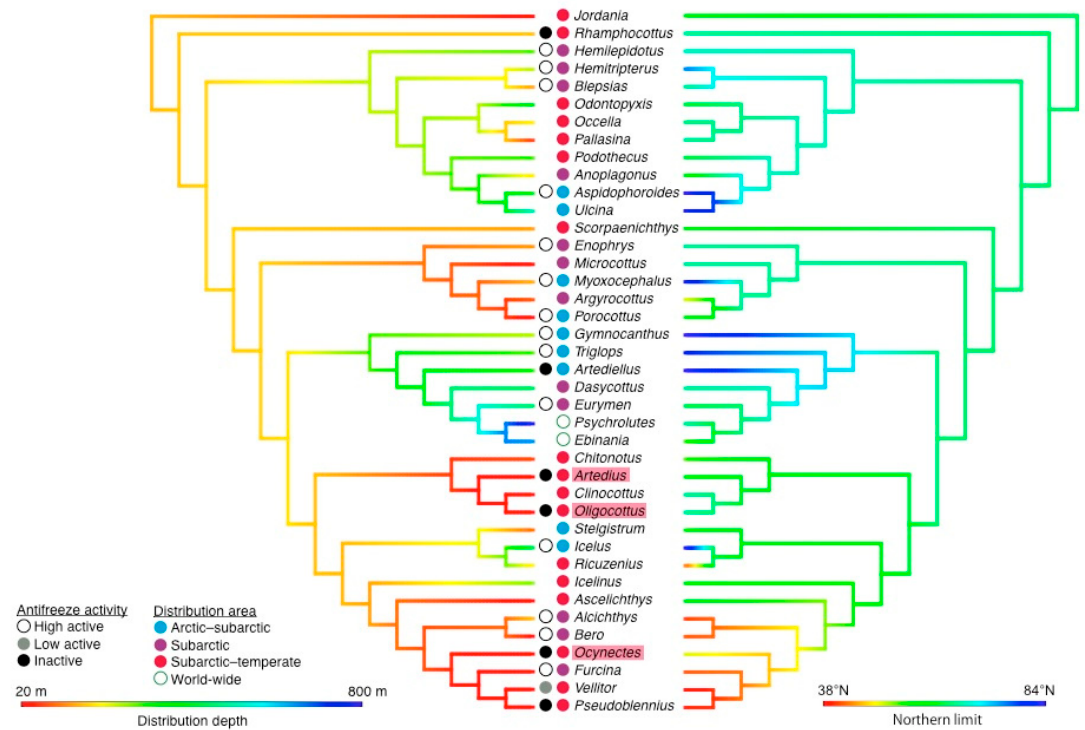
Figure 3. Molecular phylogeny and antifreeze activity in the superfamily Cottoidea. White, grey, and black circles represent genera with high, low, and no antifreeze activity. Colored circles represent the distribution area; blue, purple, and red show the genera inhabiting the Arctic–subarctic, subarctic, subarctic–temperate areas, respectively; the green-lined circles show the genera inhabiting world-wide. The left tree is colored by the distribution depth; 20 m depth is colored red and 800 m depth is colored blue. The right tree is colored by the northern limit of the distribution area; 38 ◦ N is colored red and 84 ◦ N is colored blue.